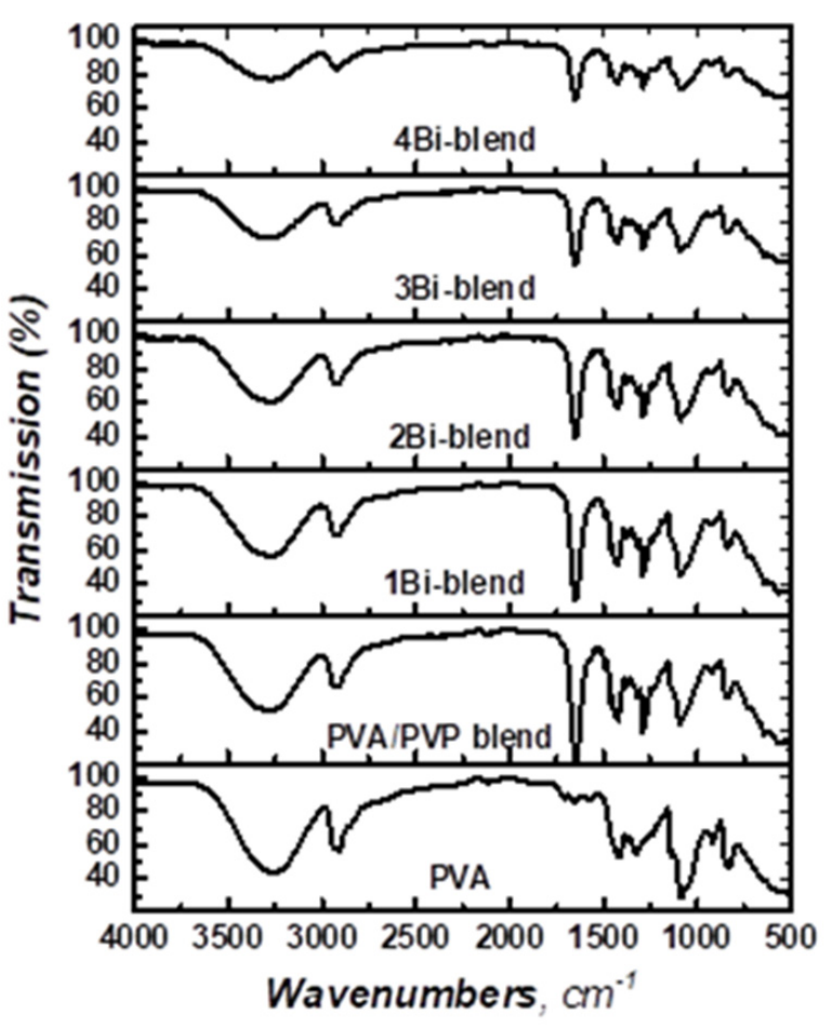
Figure 3. FTIR spectra of pristine PVA, PVP/PVA blend, and Bi-blend hybrid films.